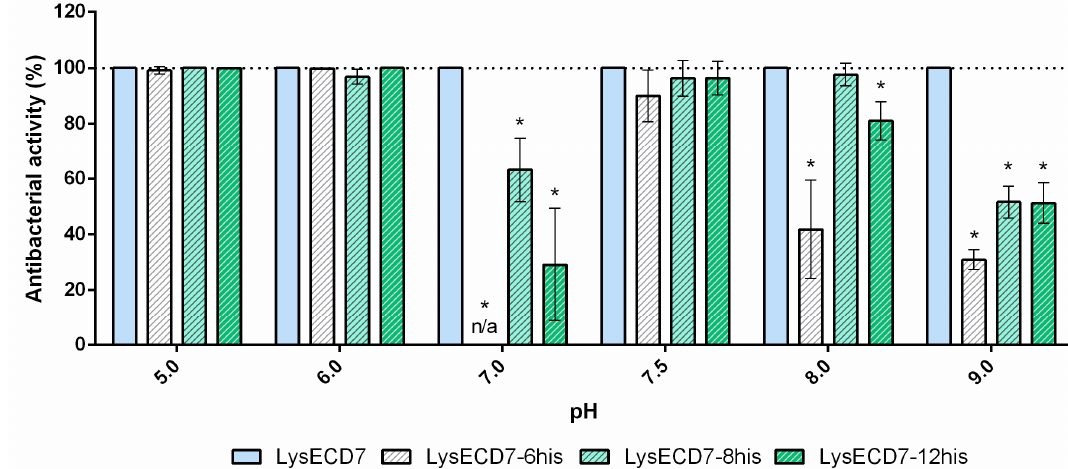
Figure 3. The e ff ect of the histidine tag on the lytic properties of LysECD7 against the A. baumannii Ts Figure 3. The effect of the histidine tag on the lytic properties of LysECD7 against the A. 50-16 strain over a pH gradient range at a protein concentration of 1 µ g / mL. The bacterial suspension baumannii Ts 50-16 strain over a pH gradient range at a protein concentration of 1 µg/mL. was diluted in 20 mM Tris HCl bu ff er with di ff erent pH values (5.0–9.0) to 1 to 3 × 10 5 CFU / mL and The bacterial suspension was diluted in 20 mM Tris HCl buffer with different pH values mixed with the proteins. For all experiments, the mean values are shown from three independent (5.0–9.0) to 1 to 3 × 10 5 CFU/mL and mixed with the proteins. For all experiments, the mean experiments ( ± standard deviation, SD). n / a, no bactericidal activity detected. An asterisk (*) indicates values are shown from three independent experiments (± standard deviation, SD). n/a, no a significant di ff erence in bactericidal activity compared to the LysECD7 enzyme ( p < 0.05, two-way bactericidal activity detected. An asterisk (*) indicates a significant difference in bactericidal ANOVA with Dunnett’s multiple comparisons activity compared to the LysECD7 enzyme ( p < 0.05, two-way ANOVA with Dunnett’s multiple comparisons test).